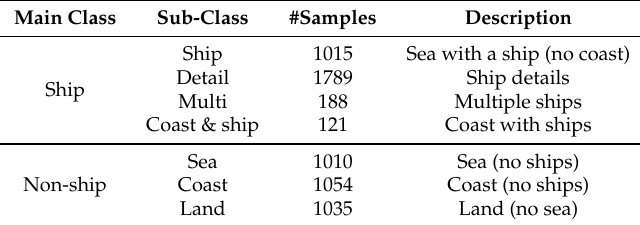
Figure 2. Image examples of different classes from the dataset created. The first four rows show the ship classes, in which the “detail” class is used only to enhance the training process. The three lower rows show the non-ship categories. It will be noted that the dataset samples are highly varied and that the categories “ships” and “ships with coast” contain very difficult images. Table 3. Distribution of the classes in the MASATI